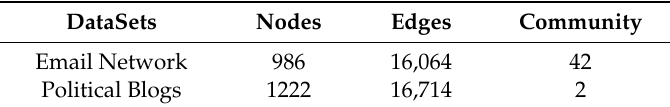
Table 1. Datasets for verifying representation e ff ect.